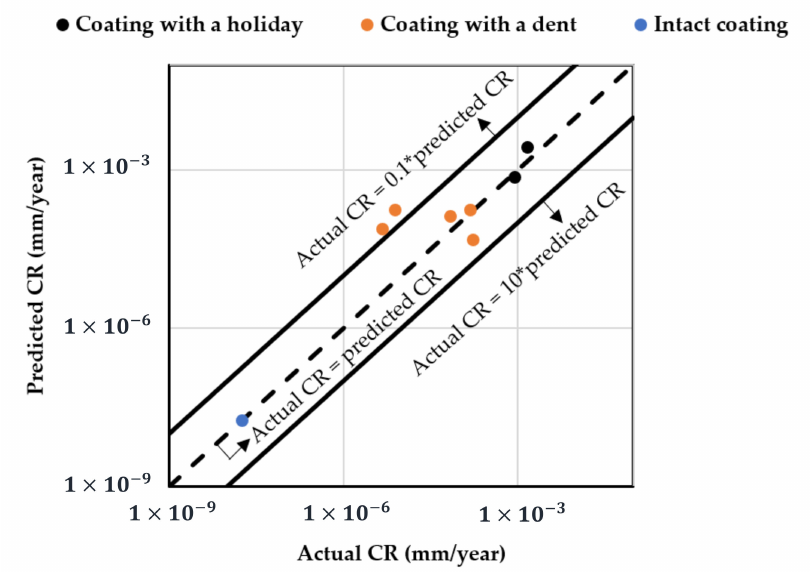
Figure 8. Predicted CR vs. Actual CR for coated samples tested at pH